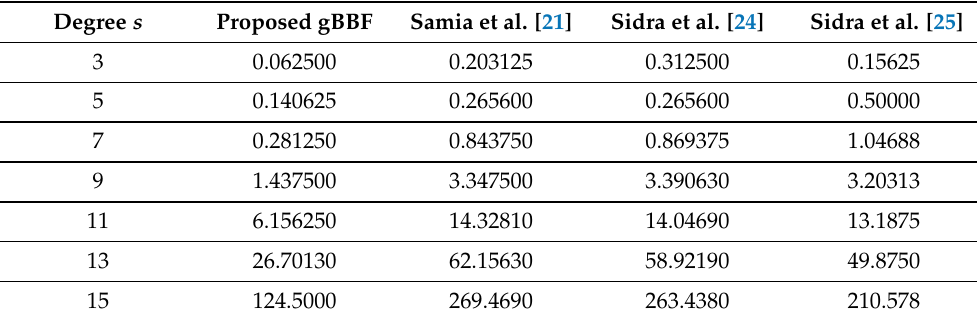
Table 3. Comparison of graphical outcomes of gBBF between existing Bernstein-like basis functions in terms of CPU time (s). Degree s Proposed gBBF Samia et al. [21] Sidra et al. [24] Sidra et al.